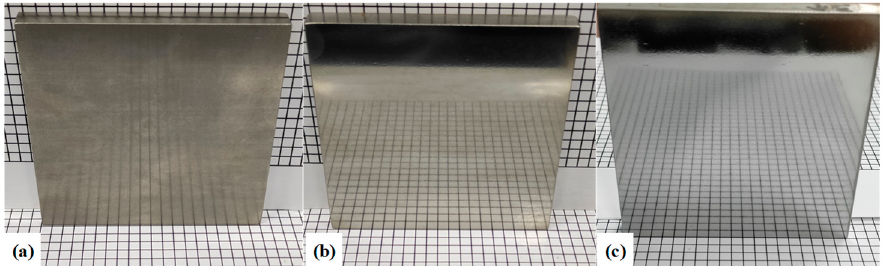
Figure 11. Comparison of titanium alloy surface effects before and after polishing with SR bonnet and PR bonnet: ( a ) Before polishing, ( b ) uniform polishing after SR bonnet, and ( c ) uniform polishing after PR bonnet.